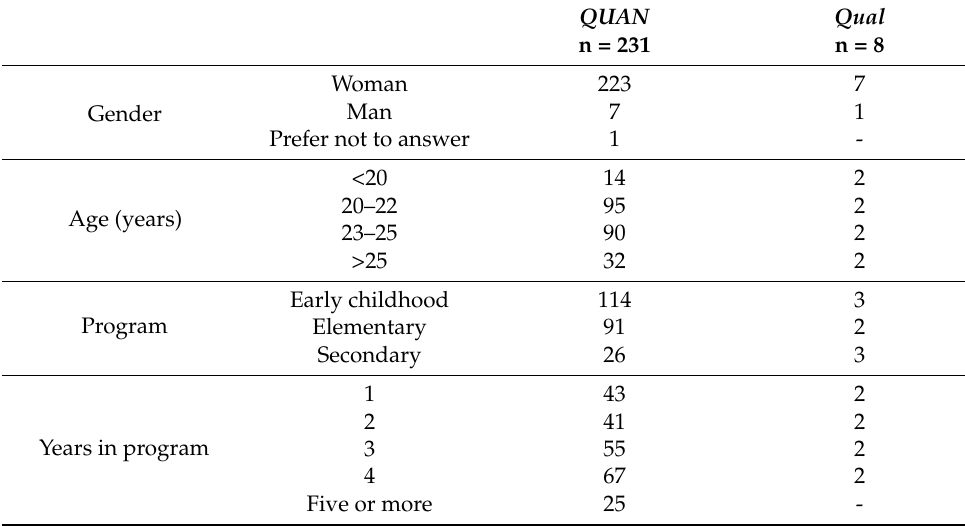
Table 1. Socio-demographic characteristics of the